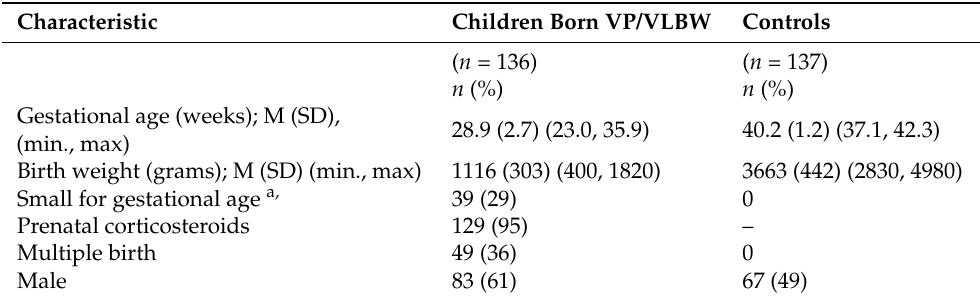
Table 1. Background characteristics of very preterm/very low birth weight (VP/VLBW) children and full-term controls. Numbers (percentages) are shown. If mean (standard deviation) [minimum, maximum] are presented, they are indicated